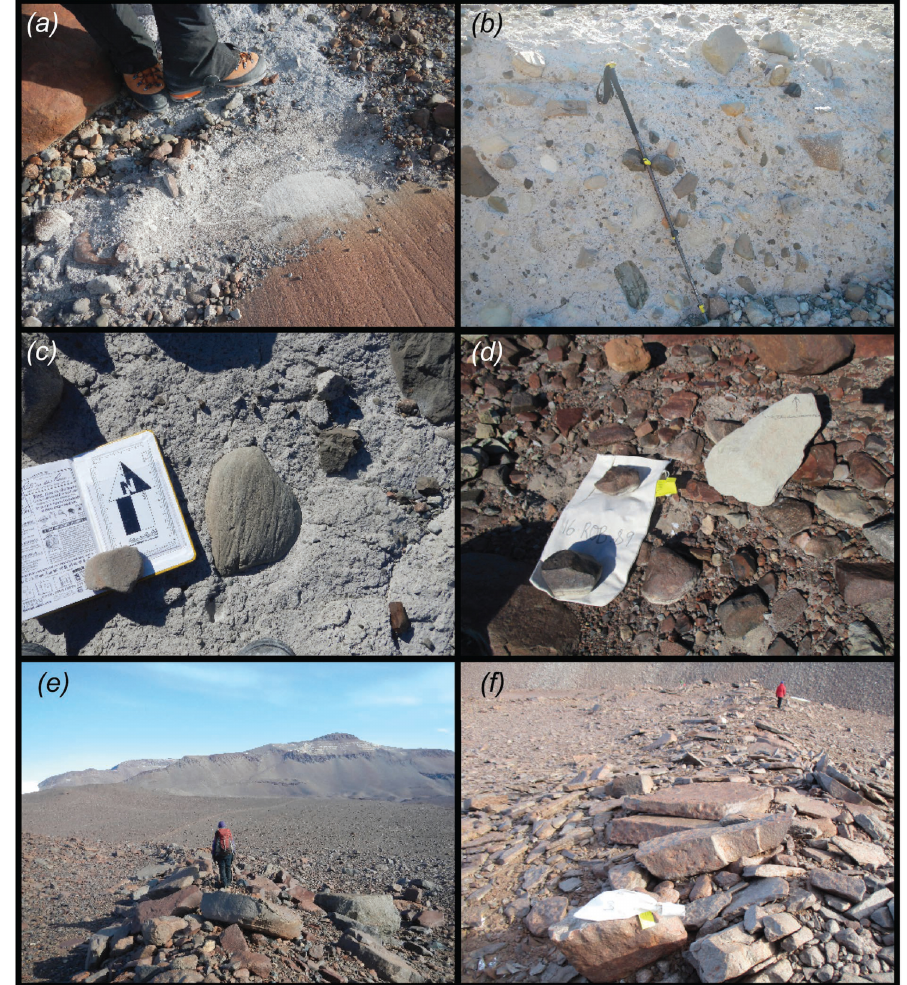
Figure 5. Views of drifts and tills described at Roberts Massif. (a) The gray, fine-grained Sirius Group deposits atop striated dolerite bedrock; (b) Sirius Group exposed in section in the Bowl, with 120cm long pole for scale; (c) striated, glacially molded Sirius cobble embedded in a fine-grained matrix; (d) sample 16-ROB-089-COL, a freshly scoured sandstone clast in the Bowl, likely deposited as a thin drift sheet atop older deposits during a Late Quaternary expansion of the EAIS; (e) cold-based AND moraine, which is Pleistocene in age; and (f) Misery B moraine, which is Miocene in